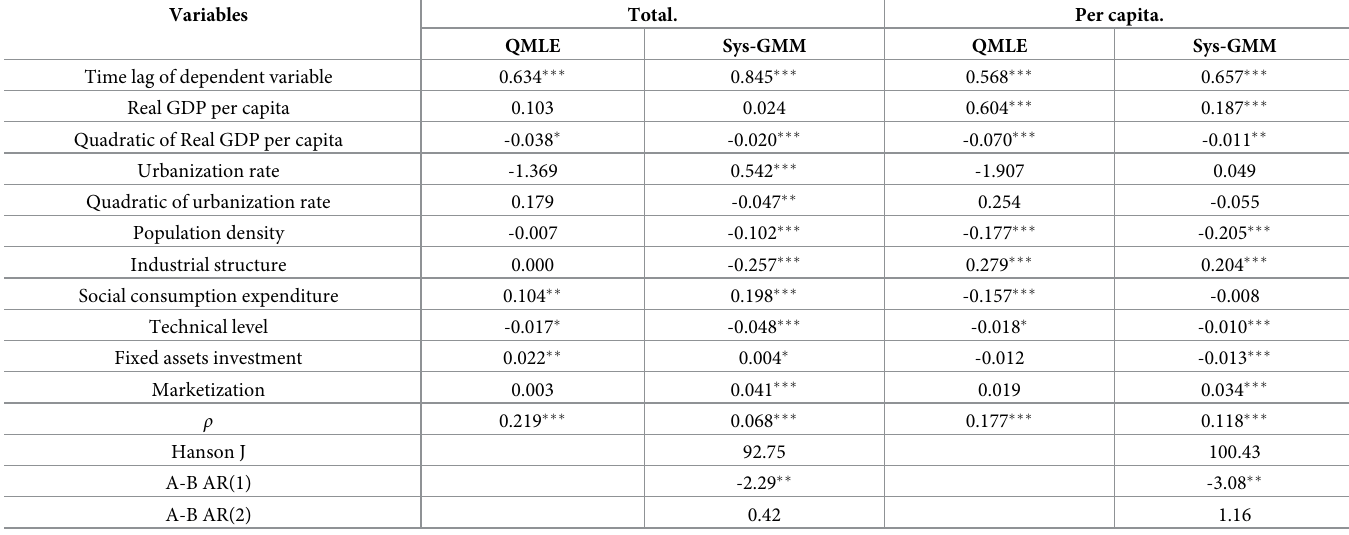
Table 5. Estimation results of spatial dynamic panel data. Variables Total.